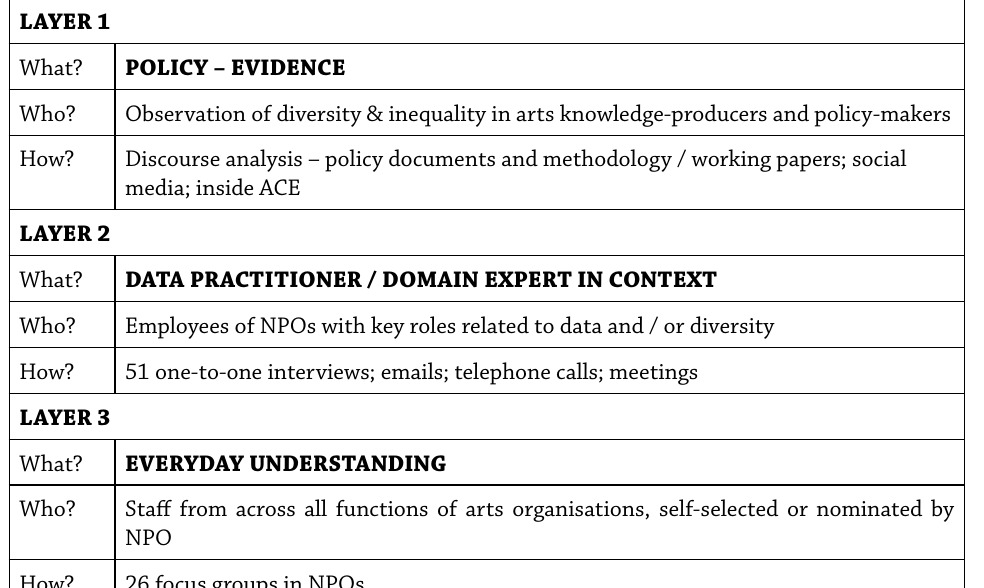
Table 4: Research design that applies the re-performance framework to diffuse policy exper- tise across the cultural